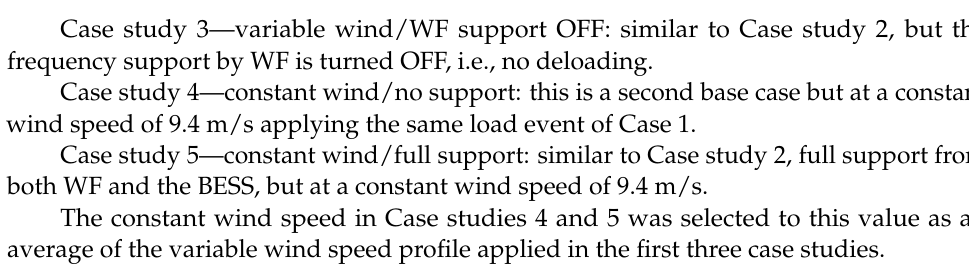
Figure 9. The variable solar irradiation applied in all case studies 1, 2 and 3.